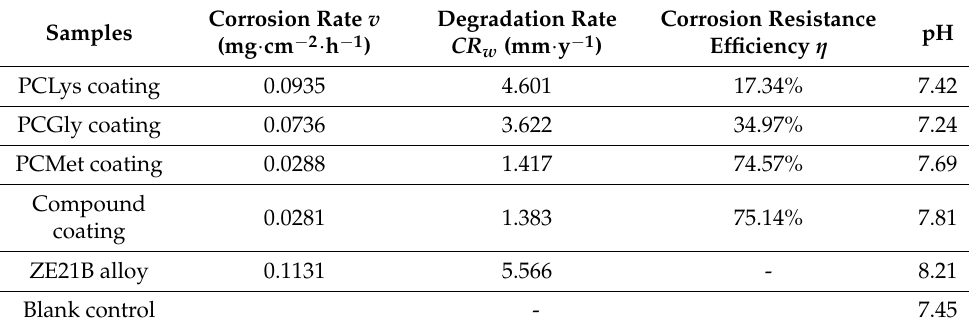
Table 3. Static weightlessness test for 72